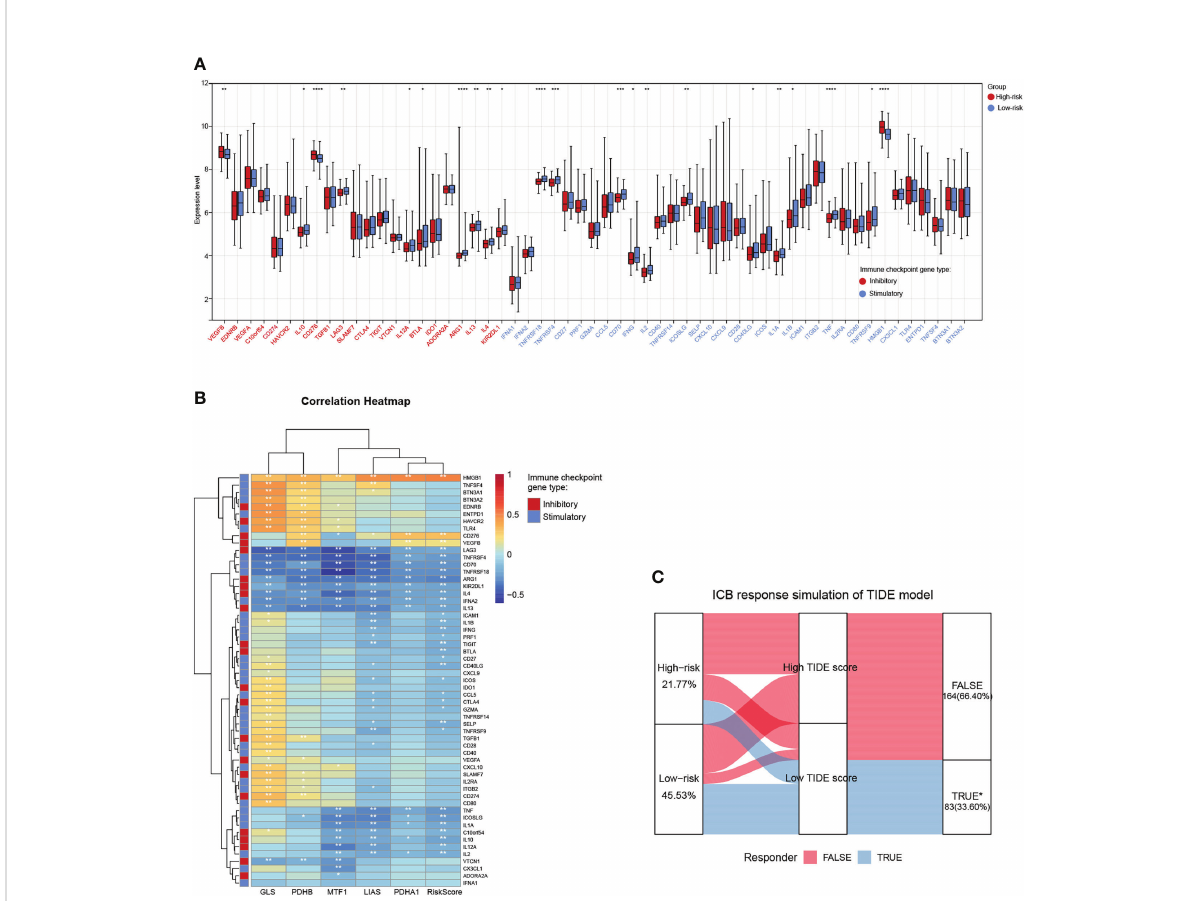
FIGURE 8 Associations between the cuproptosis signature and ICB immunotherapy. (A) Distribution of 57 immune checkpoint molecules, including 22 inhibitory- and 35 stimulatory-immune checkpoint genes in the two risk subgroups in the TARGET-NB cohort. (B) Relationships between the fi ve risk genes, riskscore, and immune checkpoint molecules. (C) Immune response difference between the high- and low-risk subgroups based on TIDE scores in TARGET-NB cohort. *, **, ***, and **** indicate a signi fi cance level of 0.05, 0.01, 0.001, and 0.0001,